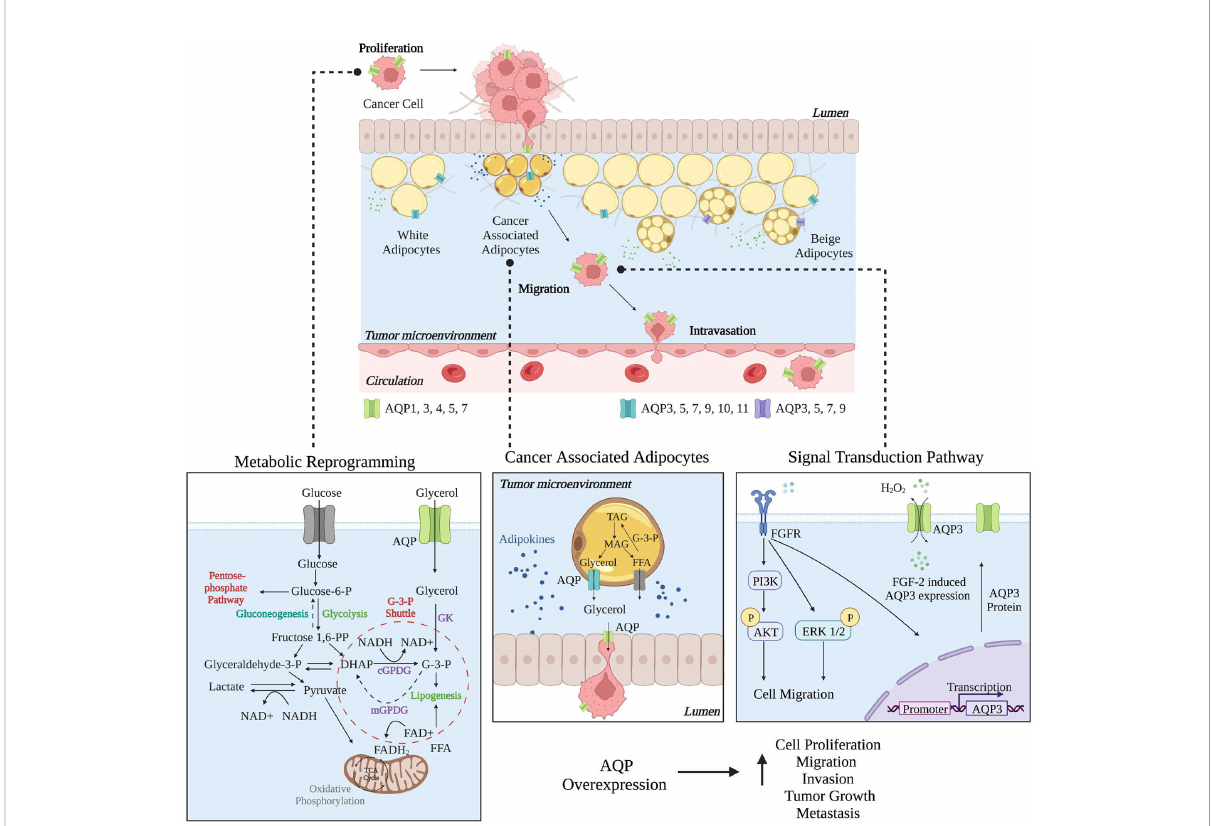
FIGURE 2 Roles of Aquaporins in Breast Cancer. In breast cancer, individual AQPs have multiple roles, from proliferation to migration to intravasation, where the cancer cells then metastasize to a secondary site. Metabolic reprogramming of cancer cells helps to support proliferation as AQPs can help to facilitate glycerol transport. In cancer-associated adipocytes (CAAs), AQP expression may be essential in facilitating glycerol transport between CAAs and cancer cells. AQP3 expression is critical in cell migration where changes in signal transduction pathways facilitate migration and AQP3 overexpression. Created with BioRender.com. This fi gure was in fl uenced by Aikman et al. (83).